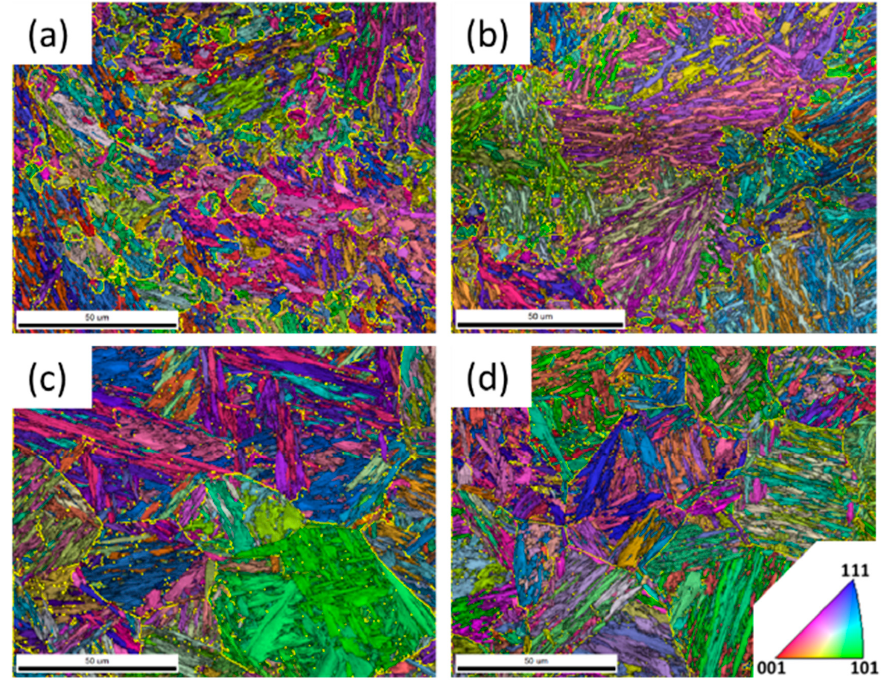
Figure 3. Representative electron Backscattered diffraction orientation image mapping (EBSD-OIM) of the ( a ) N H Q L , ( b ) N L Q L , ( c ) N H Q H , ( d ) N L Q H .